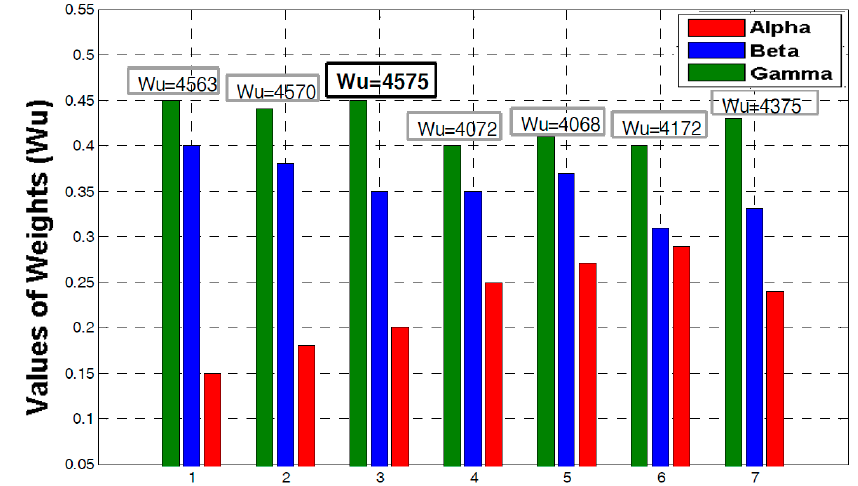
Figure 4. Node’s status (W u ) at different simulations for being a cluster head (CH).